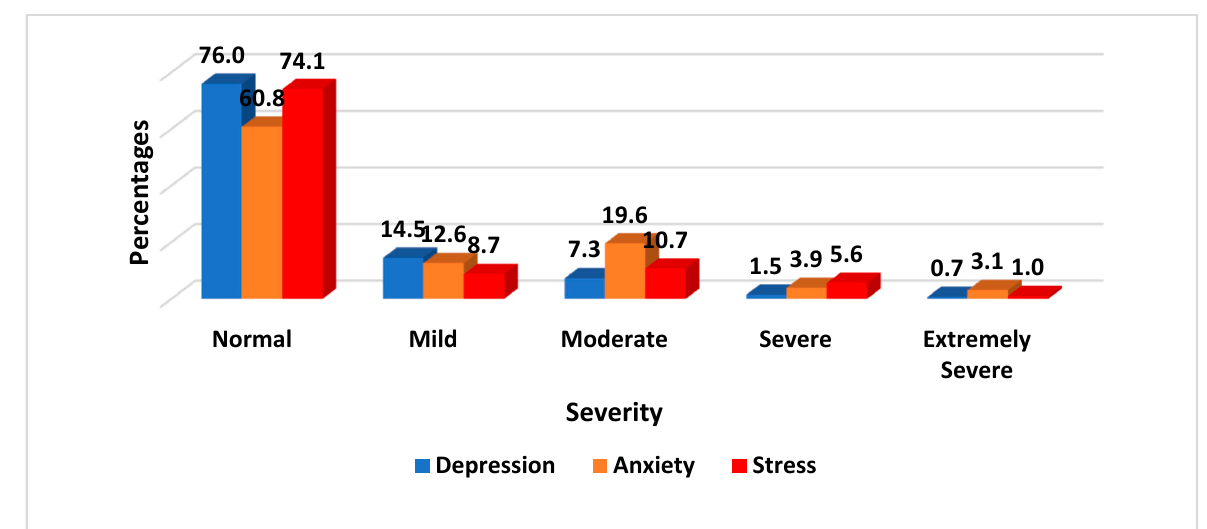
Figure 1. Degrees of depression, anxiety, and stress among the pregnant women.